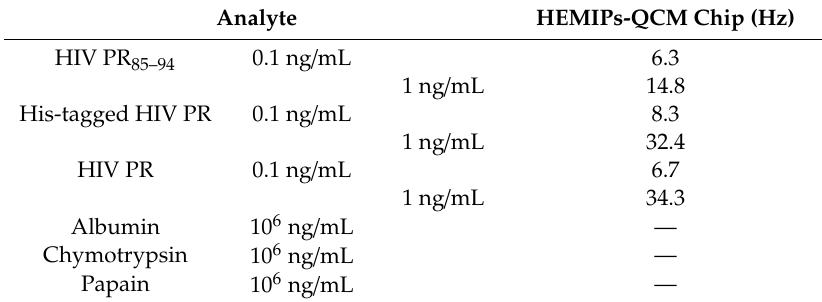
Table 1. Specificity of the HIV PR 85–94 templated HEMIPs-quartz crystal microbalance (QCM) chip.